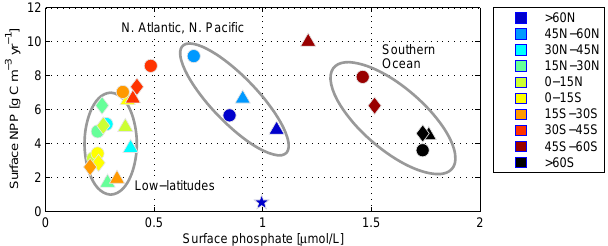
Fig. 11. Latitudinal mean of biological production as a function of mean surface phosphate concentration. The symbols represent dif- ferent ocean basins: the ( ? ) Arctic, ( (cid:13) ) Atlantic, ( 4 ) Pacific, and ( ♦ ) Indian Ocean basins.